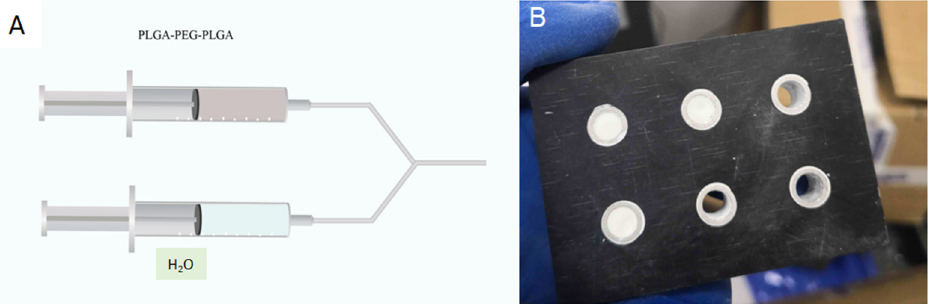
Figure 1. Preparation of PLGA–PEG–PLGA/C 3 S/C 2 S/POP composite bone cement column: ( A ) bone cement liquid phase mixing injection device; ( B ) PTFE cylinder mold. cement liquid phase mixing injection device; ( B ) PTFE cylinder